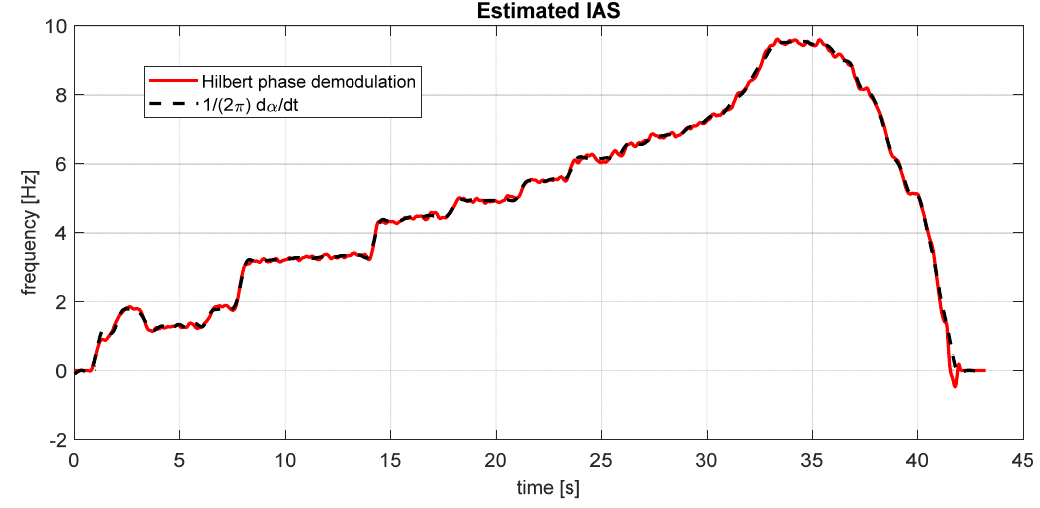
Figure 11. Final Instantaneous Angular Speed (IAS) estimates from the SURVISHNO video.